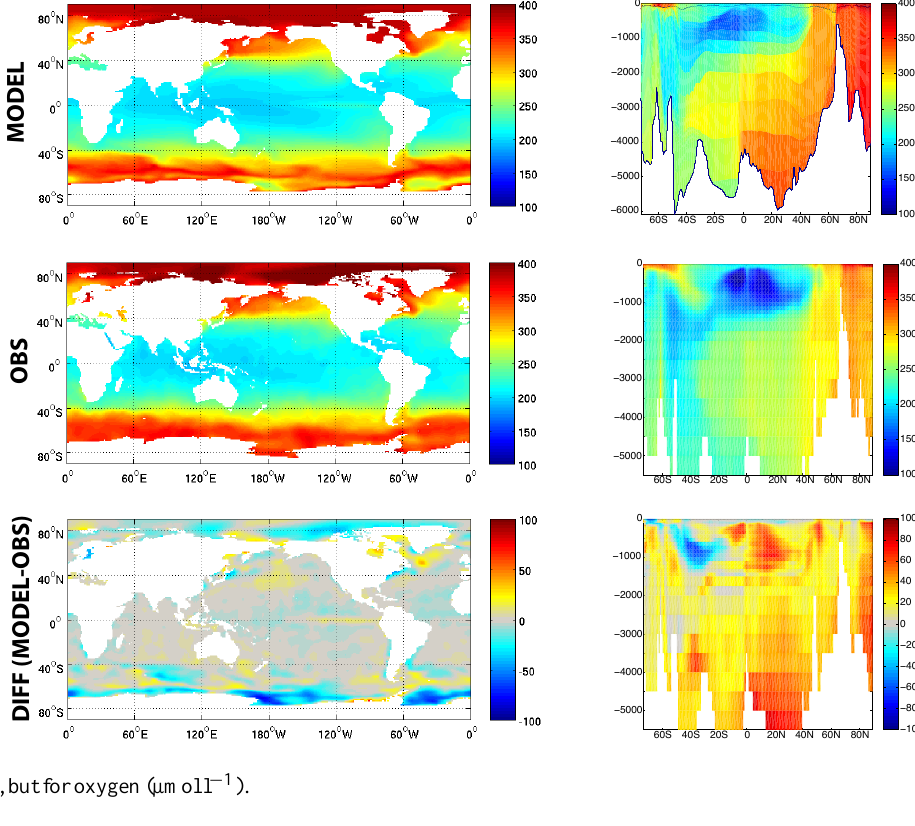
Fig. 11. As Fig. 3, but for oxygen (µmoll − 1 ).